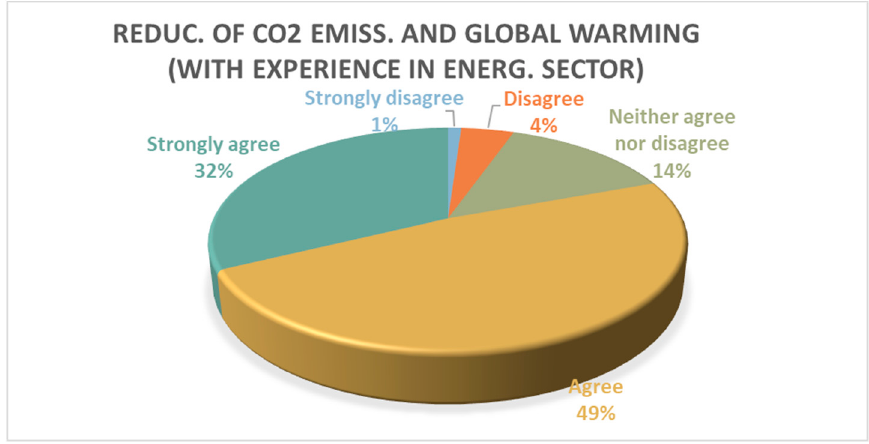
Figure 9. Participation of consumers with experience in the energy field in DR programs in order to reduce CO 2 emissions and the climate change impact.